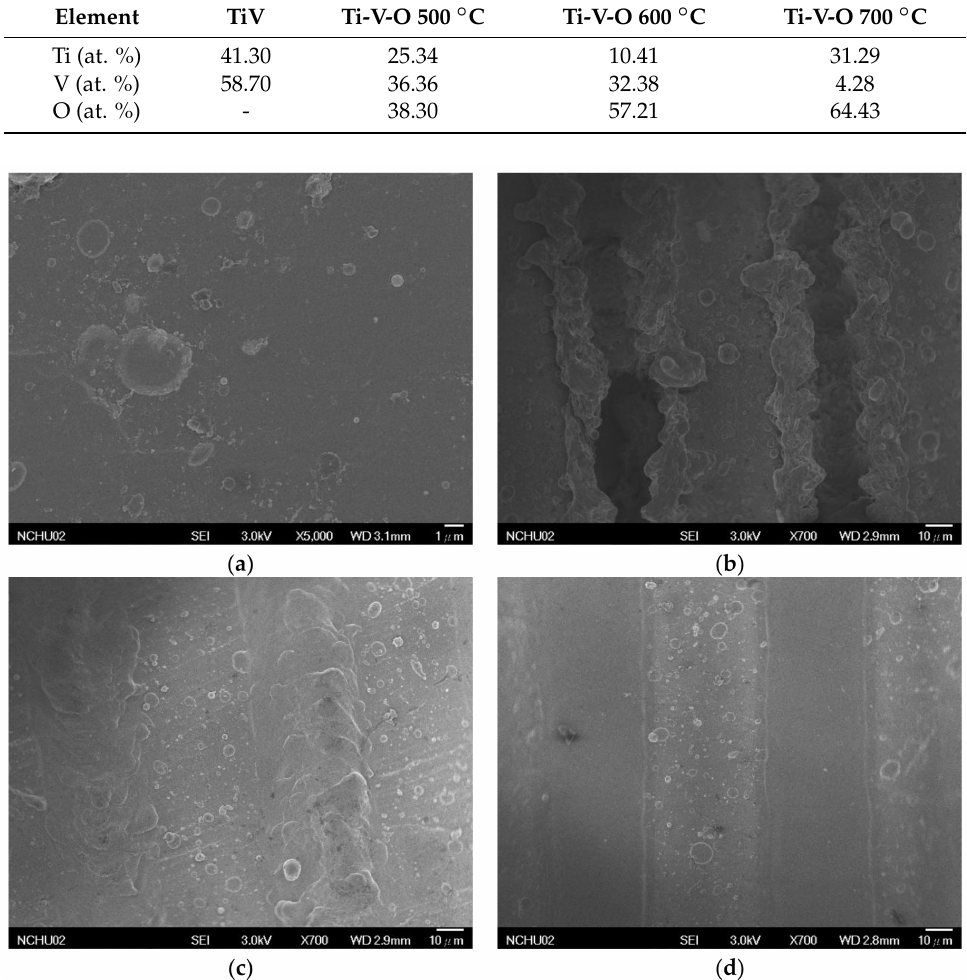
Figure 3. Surface morphology of the TV coatings and the Ti-V-O coatings following LSTO. ( a ) TiV; ( b ) Ti-V-O 100 kHz; ( c ) Ti-V-O 300 kHz; ( d ) Ti-V-O 500